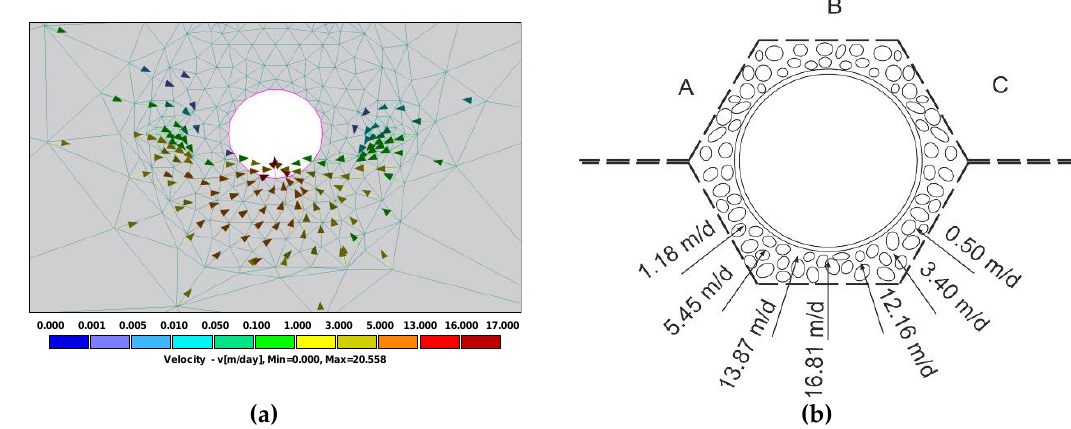
Figure 16. Distribution of seepage velocity around the drainage, ( a ) velocity vectors calculated using HYDRUS (2D/3D), ( b )scheme of vectors velocity higher than 0.00003 m/day.